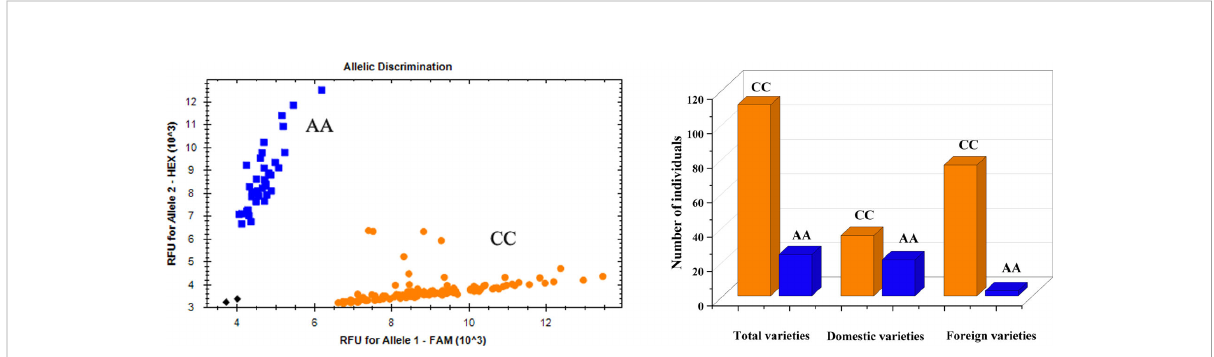
QVI.haust-4D.1/ QSL.haust-4D.2 /QRL.haust-4D